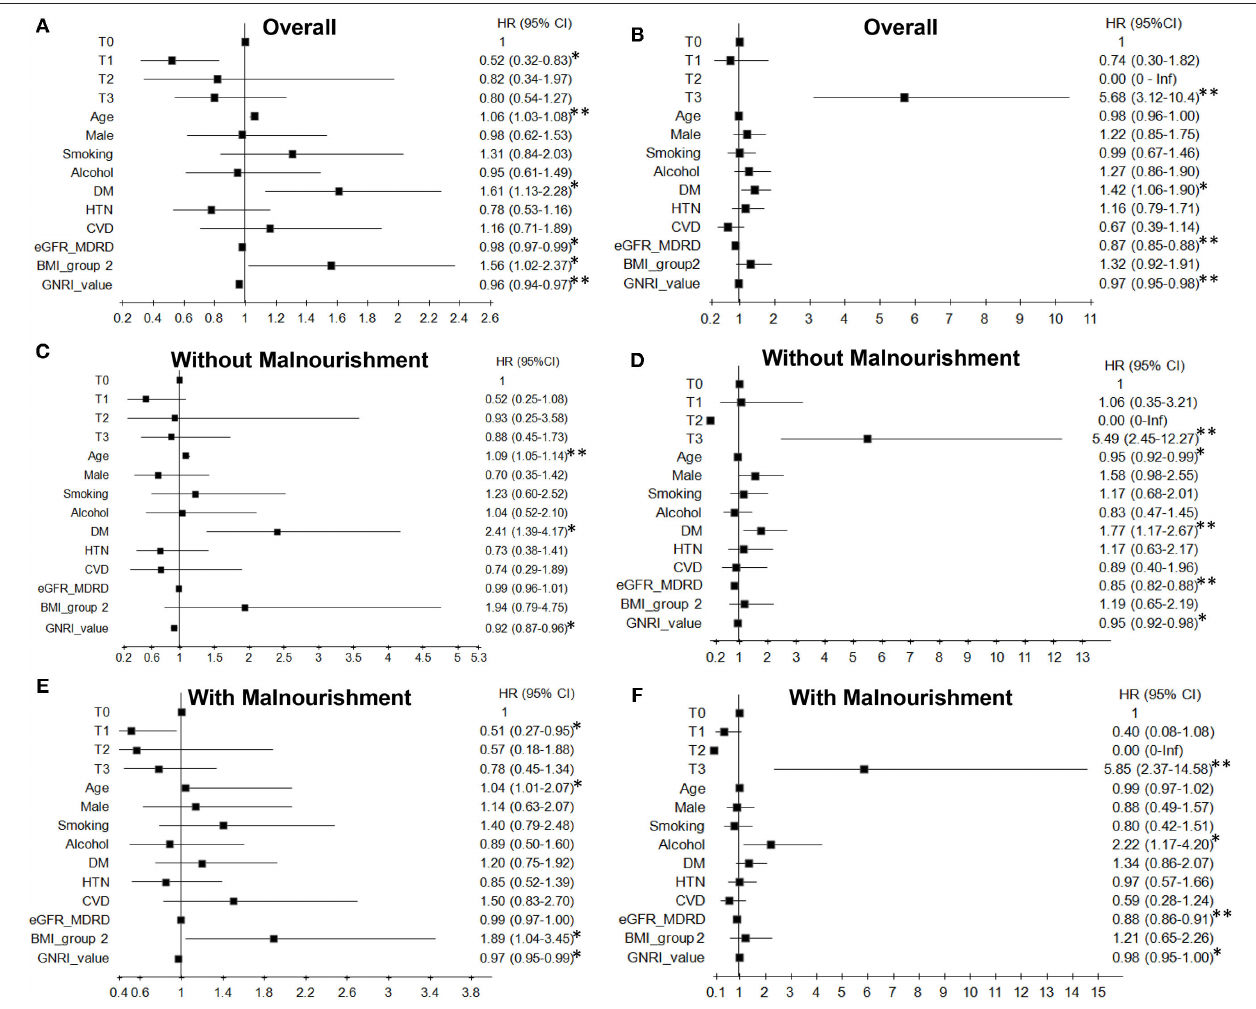
FIGURE 3 | Effects of kidney function trajectories and malnourishment on all-cause mortality (A,C,E) and kidney failure (B,D,F) among older adults. 1,872 older patients were investigated, and the outcomes were fully adjusted for demographics, laboratory parameters, clinical comorbid conditions, GNRI, and medication. There were no kidney failure events for the eGFR trajectory T2 pattern. HR, Hazard ratio; CI, confidence interval; DM, diabetes mellitus; HTN, hypertension; CVD, cardiovascular diseases; BMI_group 2, BMI cut-off point 24 kg/m 2 . The normal BMI value: male is 19.2–23.7 kg/m 2 and female is 18.3–22.7 kg/m 2 (32). * p < 0.05, ** p <